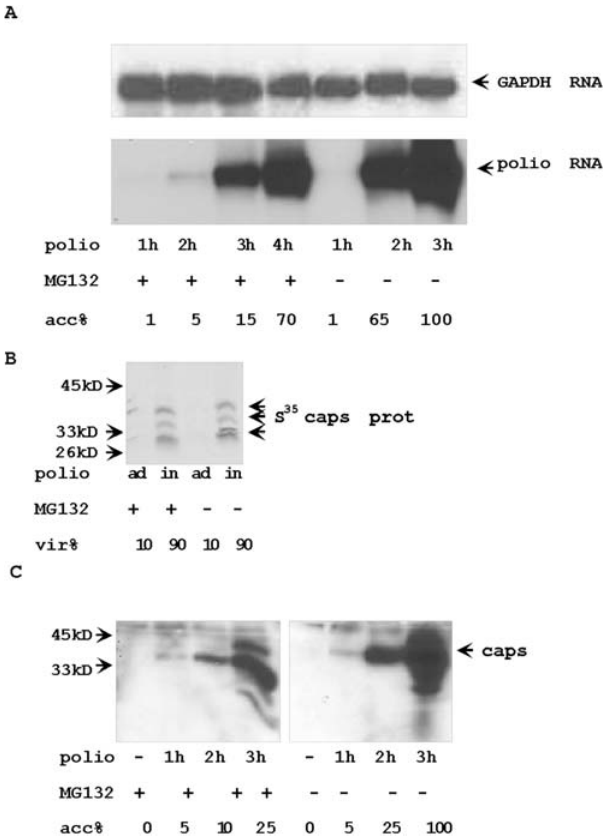
Figure 5. (A) The accumulation of poliovirus RNA was delayed but not abolished in MG132 treated poliovirus-infected cells. Northern blot hybridization of 5 m g of total RNA from poliovirus infected cells with poliovirus protein 3C hybridization probe. Hybrid- ization with GAPDH gene was a RNA loading control. (B) The inhibition of proteasome activity does not affect the entrance of poliovirus into the cells. MG treated and control HeLa cells were pre-incubated with S 35 -labeled poliovirus (MOI=100) for 1 h at 4 u C. To estimate adsorption background, cells (ad) were washed with cold PBS. Virus internalization (in) was estimated by accumulation of S 35 -labeled poliovirus capsid proteins during additional 1 h incubation at 37 u C. S 35 -labeled proteins were analyzed by electrophoresis and autoradiography. (C) Poliovirus capsid proteins accumulate slower in MG132 pretreated cells. The extracts from poliovirus-infected cells were analyzed with anti- poliovirus capsid Abs. Control or MG132 2 h pretreated cells were incubated with poliovirus (MOI=5) for 1 h. Virus containing medium was washed out and cells were incubated for indicated time. 10 m g of protein from infected cells were analyzed by Western blotting with anti- poliovirus capsid Abs.